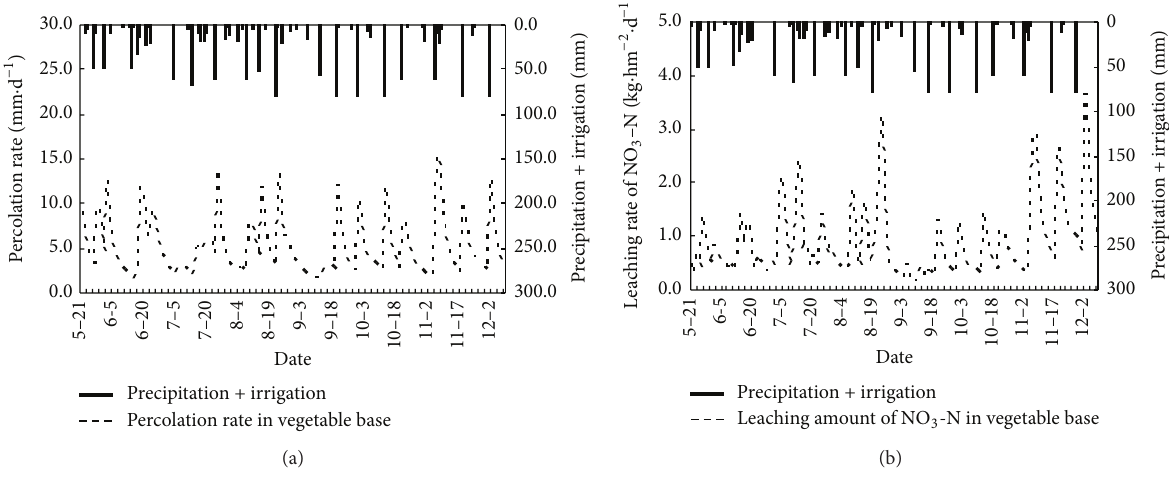
0.05.010.015.020.025.030.0